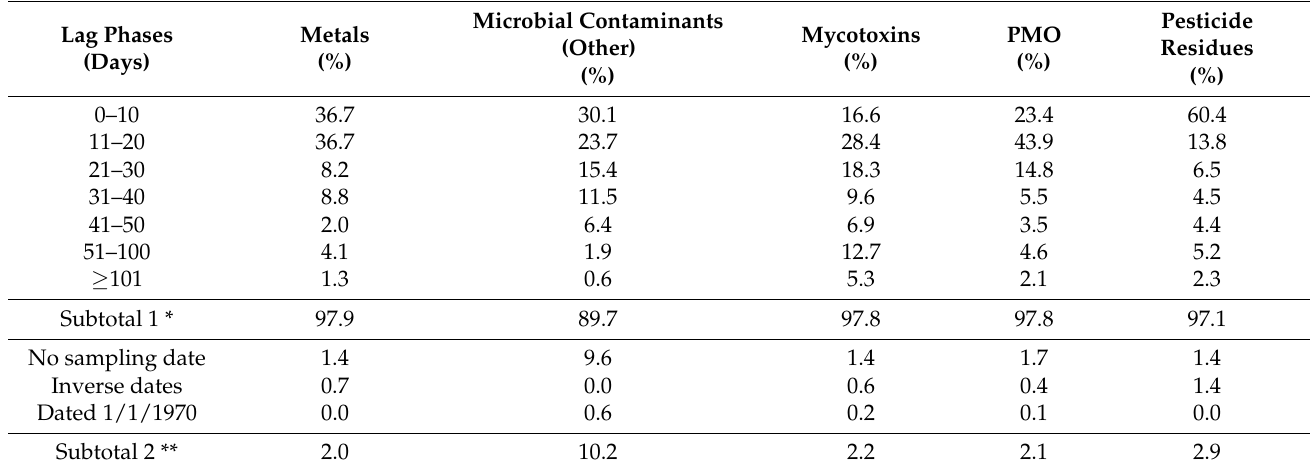
Table 7. Percent (%) share of lag phases in sBR notifications of the five food hazard categories (mycotoxins, microbial contaminants (other), pesticide residues, metals, pathogenic microorganisms (PMO)) for all EU RASFF MS collectively, originating from the EU RASFF database